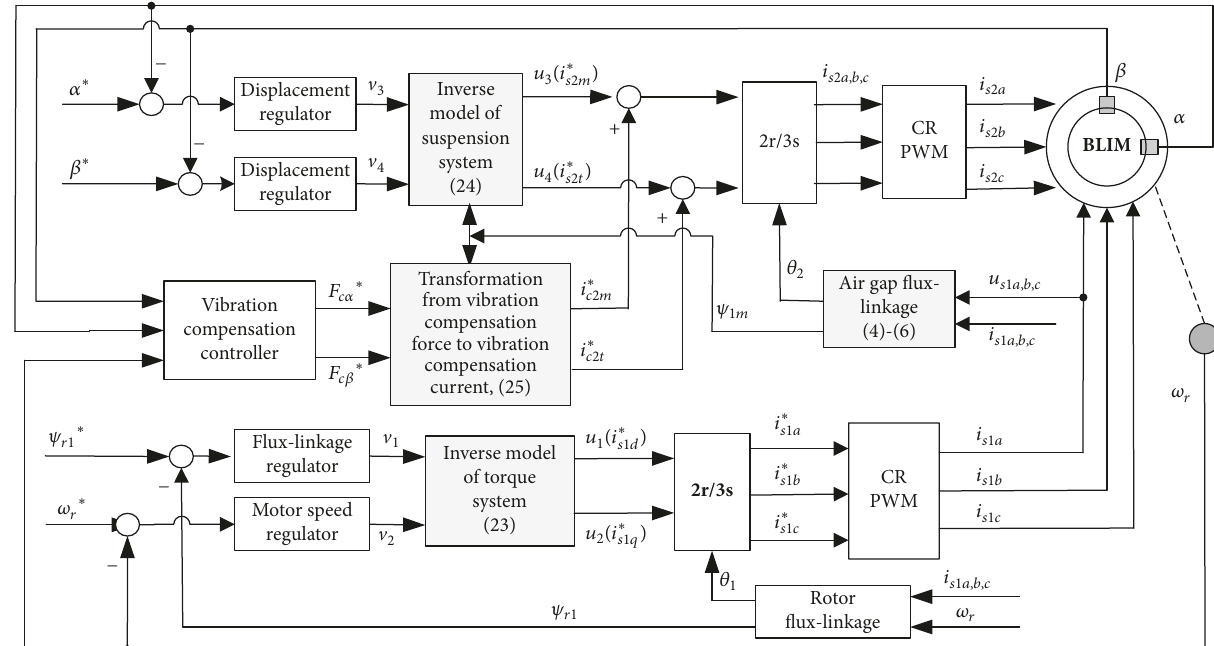
Figure 4: Unbalance vibration control system of bearingless induction